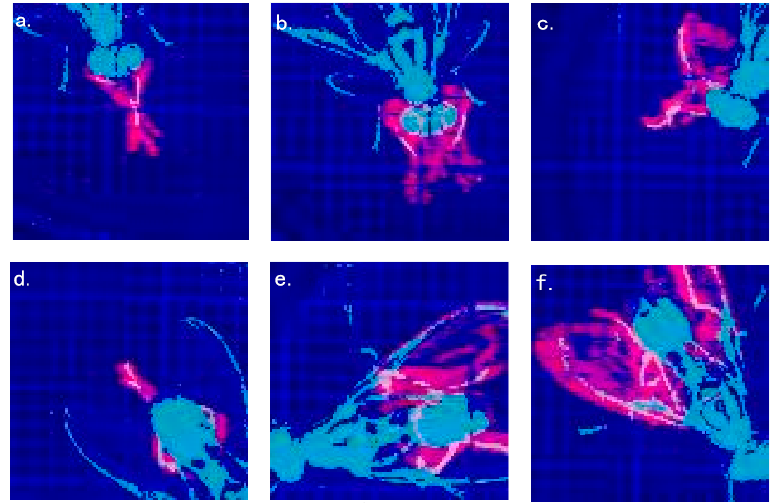
Figure 7. The result of each behavior feature image; ( a ) Foreleg grooming; ( b ) head grooming; ( c ) foreleg grooming with the participation of middle leg; ( d ) hind leg grooming; ( e ) abdomen grooming; ( f ) wing grooming.